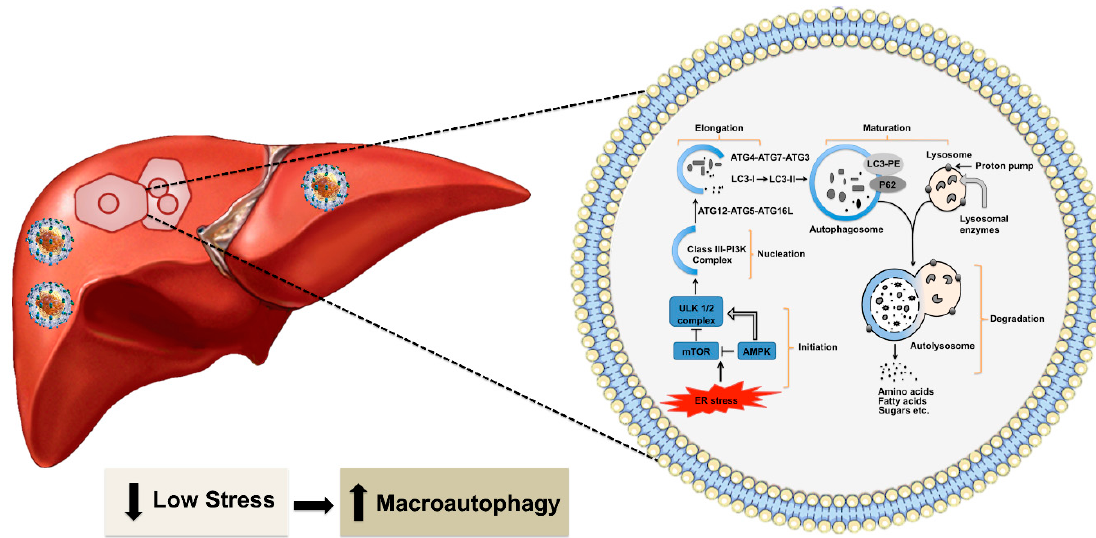
Figure 2. Shown is autophagy in the healthy liver . Hepatic autophagy supplies amino acids, glucose, and free fatty acids to meet the energy demand. Autophagy is activated by various stress signals derived from the ER that senses low energy state by MTOR1 and AMPK. The frequent target of these signaling pathways is the ULK complex consisting of ULK1/2, ATG13, RB1 inducible coiled-coil protein 1 (FIP200) and ATG101). This triggers the nucleation of the phagophore by phosphorylating components of the class III P13K (P13KC3) complex 1 [consisting of class III P13K, vacuolar protein sorting 34 (VPS34), beclin 1, ATG14, activating molecule in beclin 1-regulated autophagy protein 1(AMBRA1) and general vesicular transport factor p115], which activates local phosphatidylinositol-3-phosphate (PI3P) at ER membrane called omegasome. PI3P then recruits its effector proteins WD repeat domain phosphoinositide-interacting proteins (WIPIs) and Zinc-finger FYVE domain-containing protein 1 (DFCP1) to the omegasome. WIP12 binds to ATG16L directly, therefore, recruiting the ATG12-ATG5-ATG16L complex. This facilitates the ATG3-mediated conjugation of microtubule-associated protein 1 light chain 3 alpha (LC3) proteins. The conjugation reaction, which LC3-I is converted to LC3-II, is the characteristic features of autophagic membranes. Sealing of the autophagosomal membrane generates autophagosomes, which matures after fusion with endosome and then fuses with the lysosome. The acidic hydrolases in the lysosome degrade the autophagic cargo and nutrients are released back to the cytoplasm for reuse. The metabolites such as amino acids, sugars, and lipids are then released into the cytoplasm for the synthesis of new macromolecules.